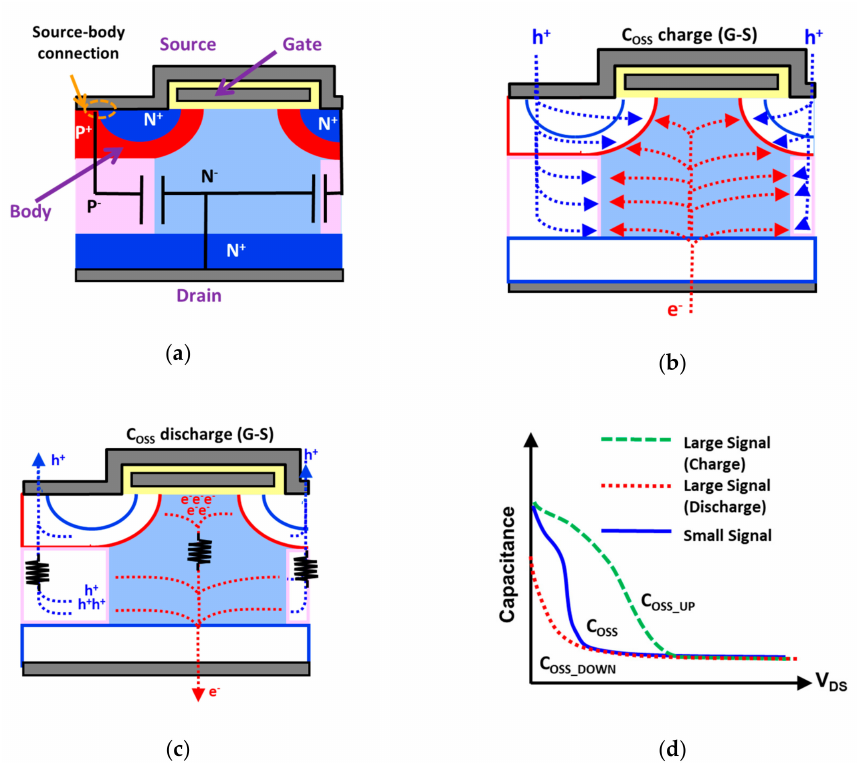
Figure 2. ( a ) Cross section of a Superjunction (SJ)-MOSFET basic cell. Description of ( b ) C OSS charge and ( c ) C OSS discharge. Electron (e-) and hole (h + ) currents and charge pockets are indicated (red and blue). ( d ) Illustrative comparison between C OSS extracted by small-signal (solid blue line) and large-signal (green dashed and red dotted